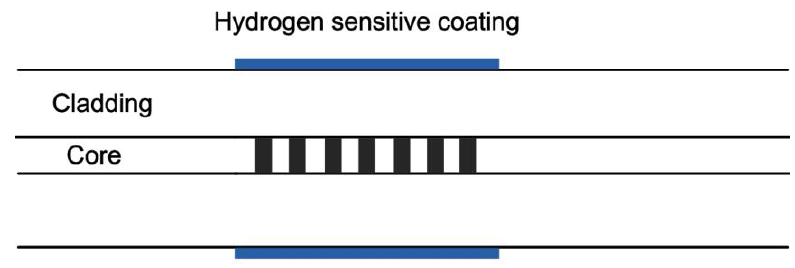
Figure 1. Typical structure of a fiber Bragg grating (FBG) hydrogen sensor [12].